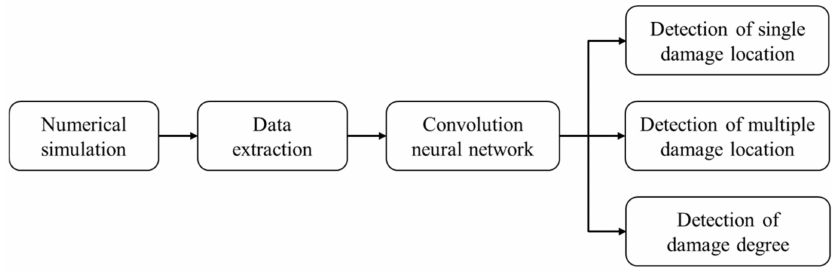
Figure 1. The overall